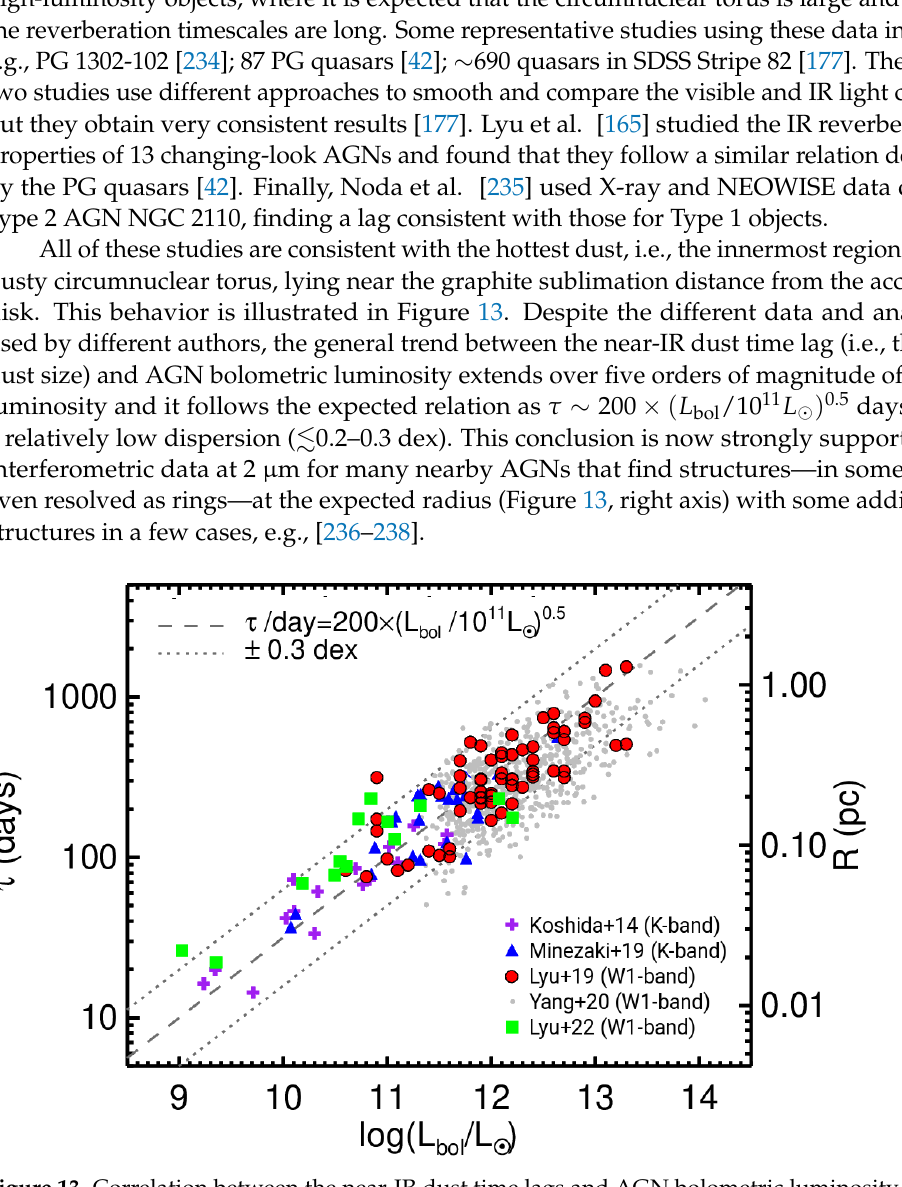
Figure 13. Correlation between the near-IR dust time lags and AGN bolometric luminosity. These measurements include the ground-based K-band ( ∼ 2.2 µ m) reverberation mapping results of ∼ 50 Seyfert-1 nuclei and quasars from the MAGNUM project [223,224], and the WISE W1-band ( ∼ 3.4 µ m), results for 87 PG quasars [42], ∼ 590 SDSS Stripe-82 quasars [177], and 13 changing-look AGNs [165]. Despite the various uncertainties and different systemics in these works, there is a strong correlation between the dust time lag and AGN luminosity over five orders of magnitude of AGN luminosity, which can be roughly described as τ ∼ 200 × ( L bol /10 11 L (cid:12) ) 0.5 days. On the secondary y-axis on the right, we also indicate the corresponding sizes of the dust emission regions assuming R = τ c , where c is the speed of